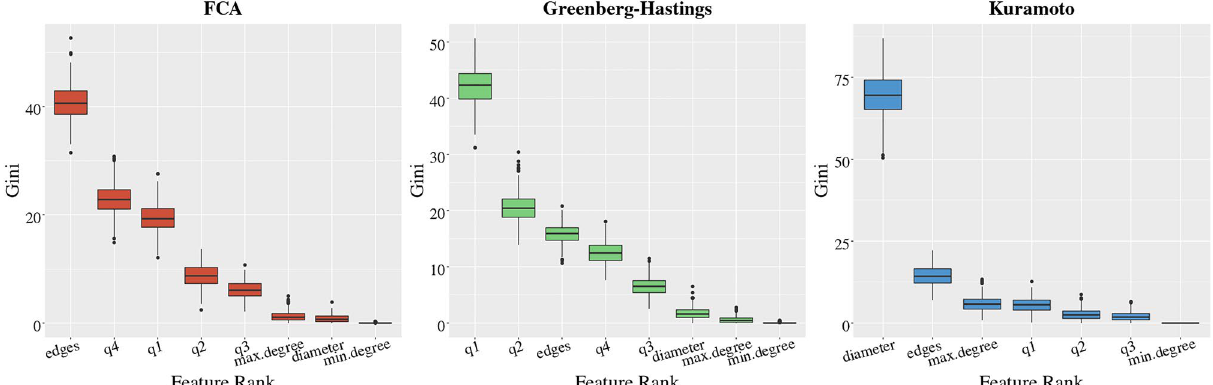
Figure 8. Boxplots of Gini index values sampled from gradient boosting procedure. Color information appears to be very important according to the distribution of Gini index values in both the FCA and GH models, discrete cellular automata models, and diameter overwhelmingly appears to have the greatest importance for